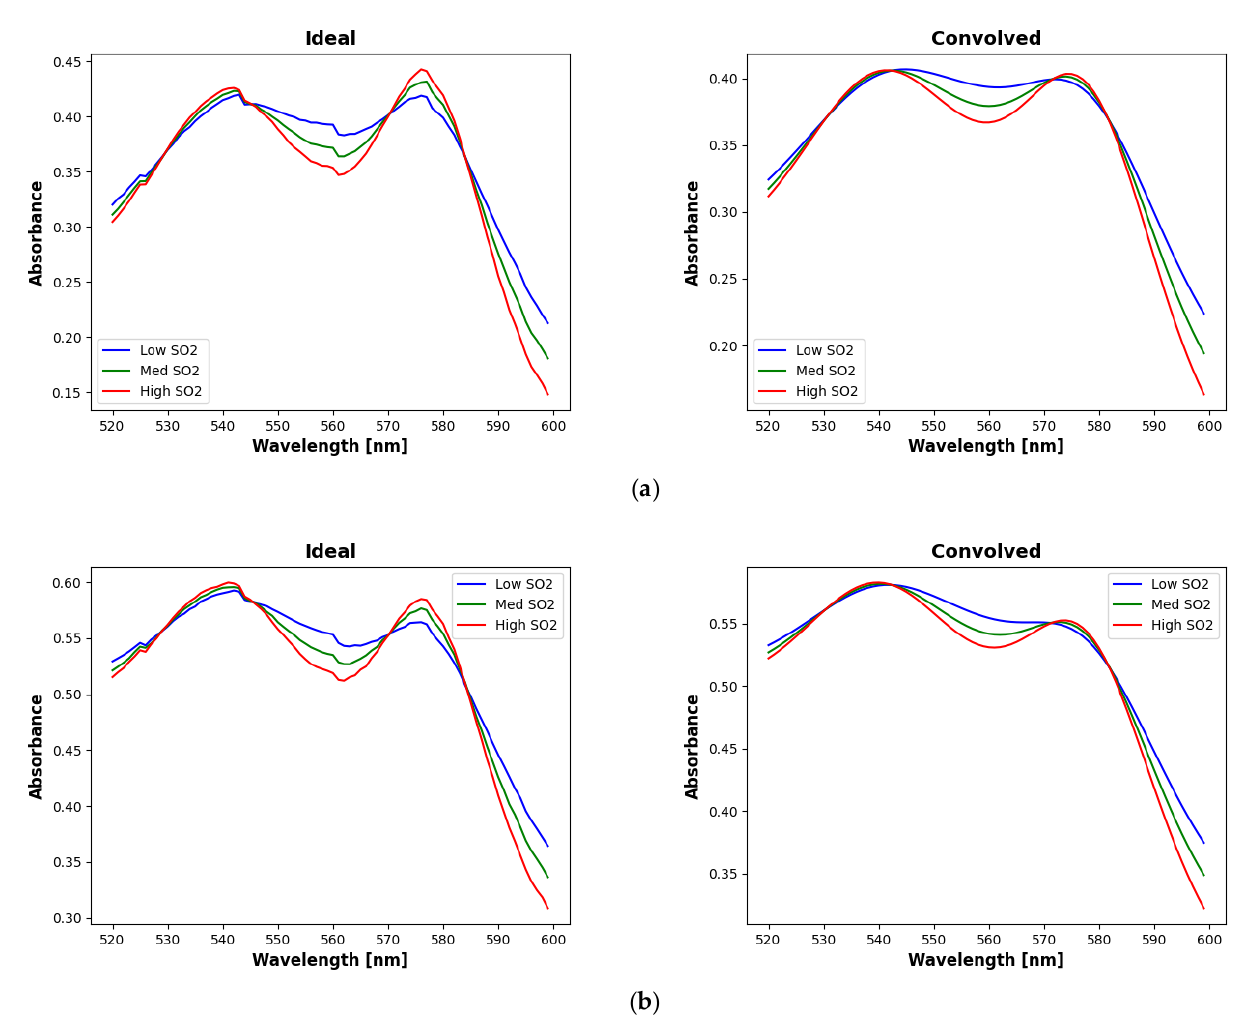
Figure 4. Wavelength selections for various values of k . The left column shows selections for the ideal case and the right column shows selections for the convolved case. ( a , f ) k = 5, ( b , g ) k = 11, ( c , h ) k = 20, ( d , i ) k = 40, ( e , j ) k = 60. The selections are superimposed on plots of the absorption coefficients for oxygenated (red) and deoxygenated (blue) hemoglobin.